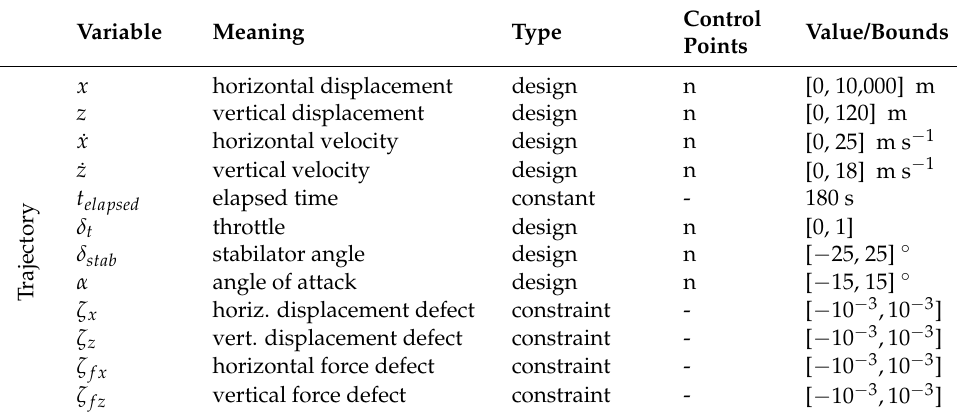
Table 3. Trajectory and control